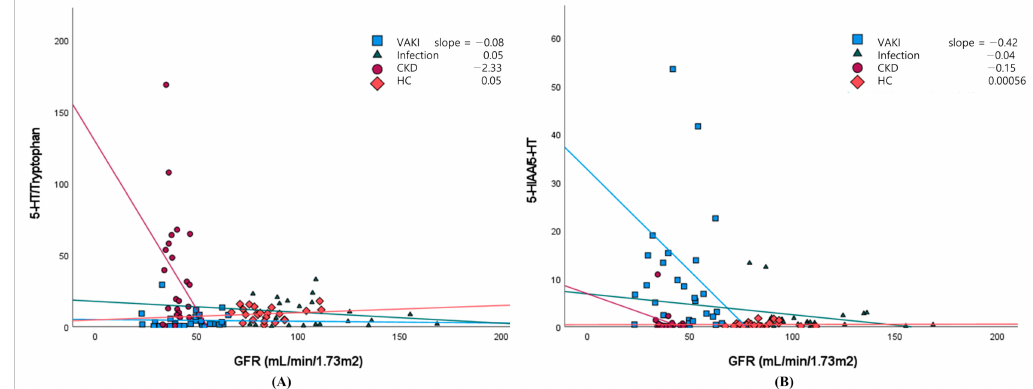
Figure 5. Scatterplots assessing the relationship between GFR and the 5-HT/Trp or 5-HIAA/5-HT ratio in the VAKI group and non-VAKI subgroups. Notes: The scatterplots assessing the relationship between GFR (mL/min/1.73 m 2 ) and the 5-HT/Trp ratio ( A ) or 5-HIAA/5-HT ratio ( B ) were plotted in the VAKI group, infection subgroup, CKD subgroup, and HC subgroup. The reference line of the 5-HT/Trp ratio showed a markedly negative slope for GFR in the CKD subgroup (purple), whereas that of the 5-HIAA/5-HT ratio showed a markedly negative slope for GFR in the VAKI group (blue). Abbreviations: VAKI, vancomycin-associated acute kidney injury; CKD, chronic kidney disease; HC, healthy control; GFR, glomerular filtration rate; SCr, serum creatinine concentration; Trp, tryptophan; 5-HT, serotonin; 5-HIAA, 5-hydroxyindoleacetic acid; 5-HT/Trp, the ratio of serotonin to tryptophan; 5-HIAA/5-HT, the ratio of 5-hydroxyindoleacetic acid to